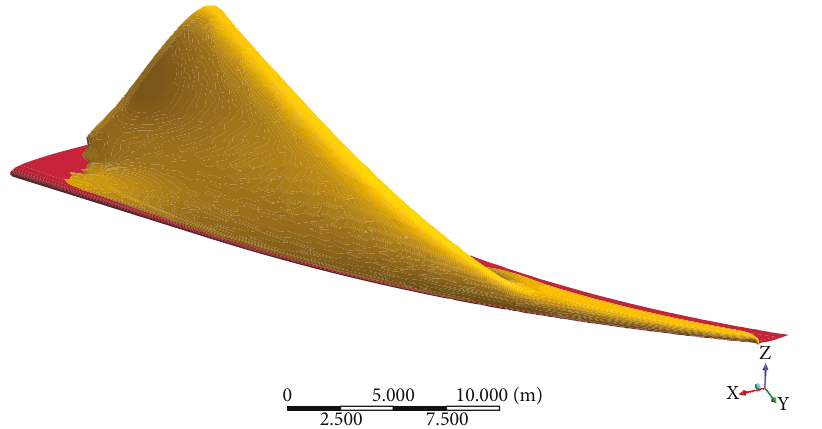
Figure 9: Supersonic region (curved wing: isoview